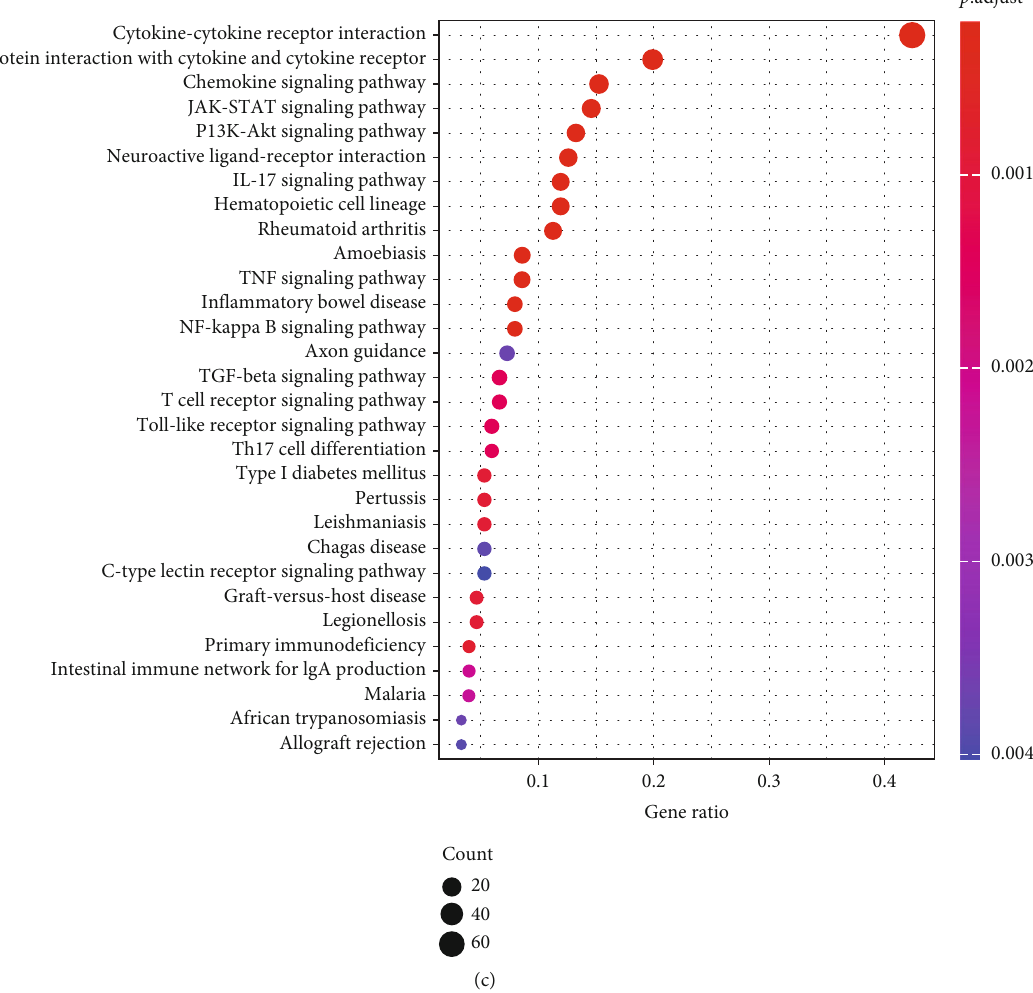
Figure 2: Di ff erential expression analysis of immune genes as well as enrichment analyses. (a) Volcano plot of IRGs of HCC. Red: markedly upregulated genes; green: markedly downregulated genes. GO (b) and KEGG (c) enrichment analyses bubble plot of